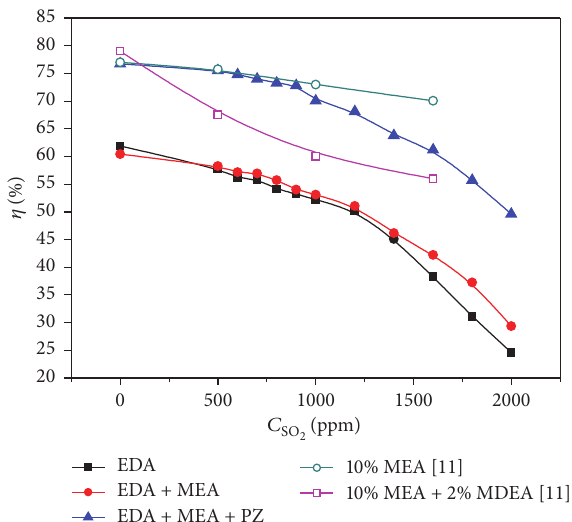
Figure 2: Influence of SO 2 concentration on the CO 2 removal = 0.7 m 3 /h, and T = 288 K). efficiency ( 𝑈 𝑔 = 4m 3 /h, U l